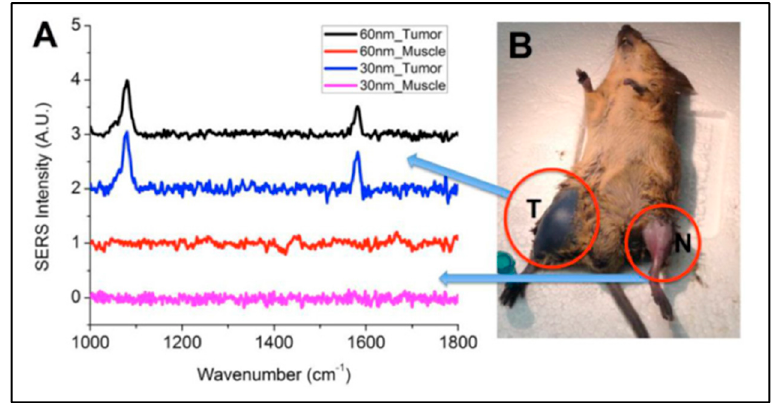
Figure 6. ( A ) In vivo SERS spectra of 30-nm and 60-nm GNS nanoprobes with MBA reporter. Unique SERS peaks can be detected at 1067 and 1588 cm − 1 in the tumor, but not in the normal muscle. The spectra are offset for visualization. ( B ) Mouse with primary sarcomas 3 days after 30-nm GNS injection. Significant GNS accumulation can be seen in the tumor (T) but not in the normal leg muscle of the contralateral leg (N). Adapted from [50].